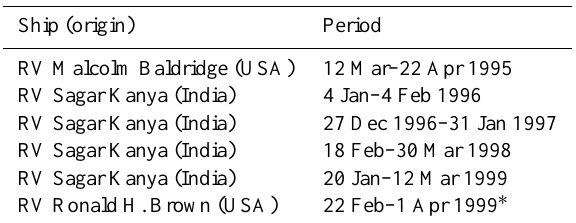
Figure 4.1.2. Cruise tracks of the 1999 RV Sagar Kaya and RV Ron Brown cruises, overlaid on the mean total cloud cover from Jan-Mar 1999 (retrieved from the METEOSAT-5 satellite radiances) [from Ramanathan et al. (2001), copyright 2001 by the American Geophysical Union, reproduced with permission].